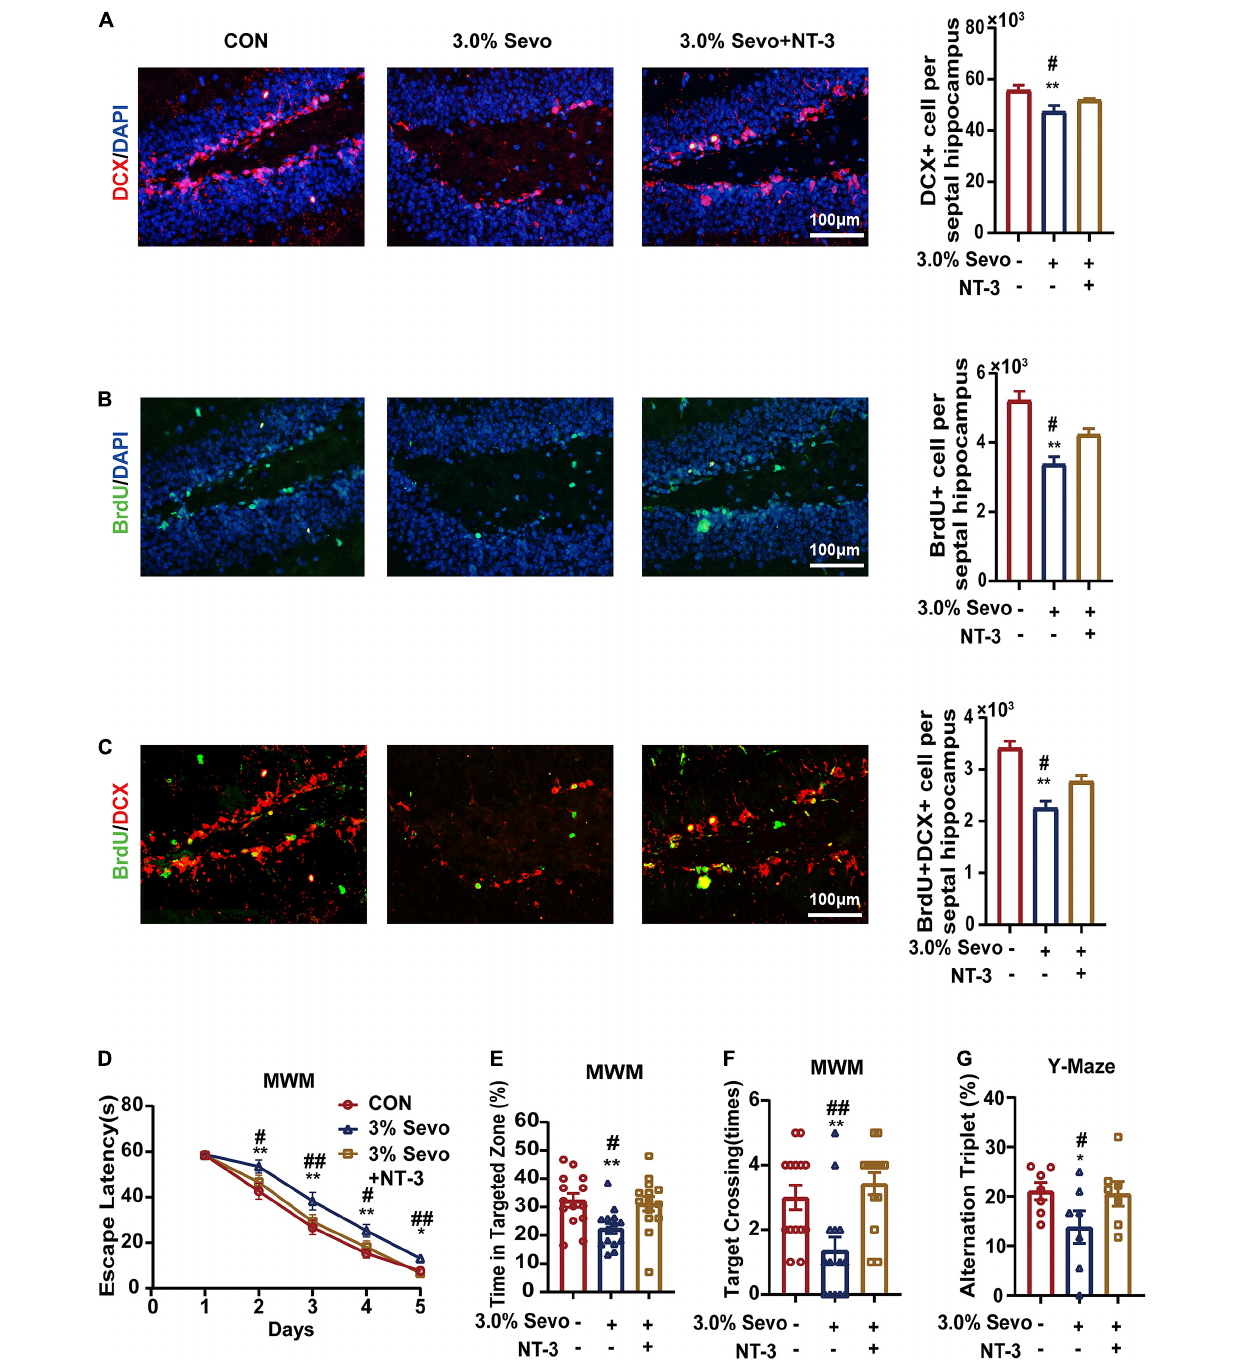
FIGURE 8 | Cognitive impairment and inhibition of AHN induced by 3% sevoflurane in aged mice could be partially prevented by NT-3. (A) Representative immunofluorescence images and quantitative analysis of DCX+ cells in aged mice. (B) Representative immunofluorescence images and quantitative analysis of BrdU+ cells in aged mice. (C) Representative immunofluorescence images and quantitative analysis of BrdU+DCX+ cells in aged mice. (D) Escape latency of the MWM during training days. (E) The percentage of time in targeted zone in testing day. (F) Times of target crossing. (G) Alternation triplet of Y-maze. Values are the mean ± S.E.M. * p < 0.05, ** p < 0.01 compared with the CON group. # p < 0.05, ## p < 0.01 compared with the NT-3 group ( n = 8/group for immunofluorescence and n = 7/group for behavioral test). MWM, Morris Water Maze Test; BrdU, 5-Bromodeoxyuridine; DCX, doublecortin; BDNF, brain-derived neurotrophic factor; TrkB, tyrosine receptor kinase B; NT-3, Neurotrophin-3; TrkC, tyrosine receptor kinase C; CON, control group; 1.5% Sevo, 1.5% sevoflurane group; 3.0% Sevo, 3.0% sevoflurane group.